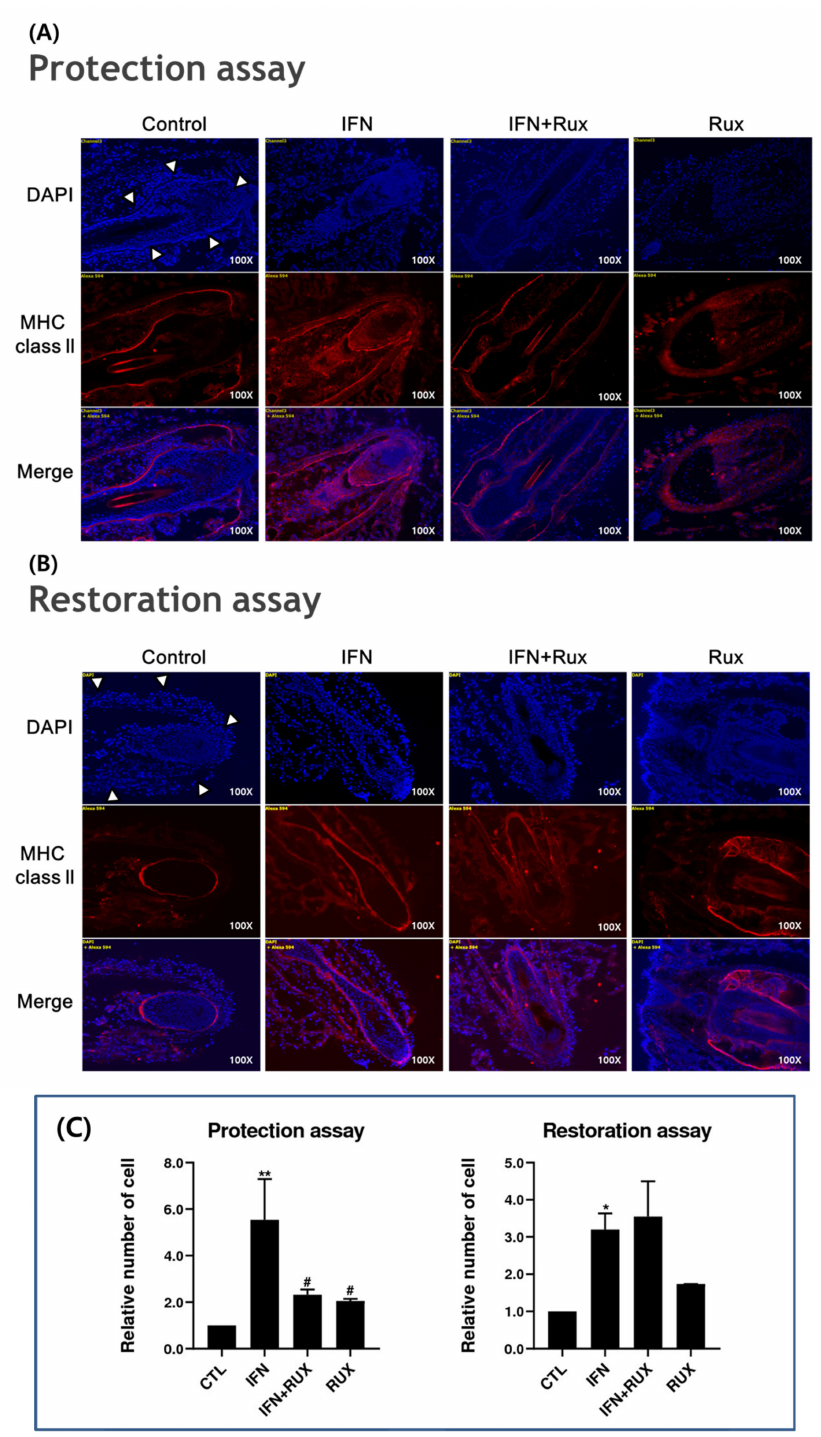
Figure 6. E ff ects of ruxolitinib treatment on hair-follicle organ culture. ( A ) Ruxolitinib pretreatment significantly prevented the induction of MHC class II molecule by IFN- γ in and around the hair follicles in the protection assay; ( B ) The expression of MHC class II molecule in the hair follicles ruxolitinib administered after treatment with IFN- γ was not e ff ectively suppressed in the restoration assay; ( C ) Relative number of immune-positive cells of MHC class II molecule in the protection and restoration assay. White arrowheads indicate outline of hair follicles. The data represent the means ± SEM, n = 3, statistically significant at * p < 0.05, and ** p < 0.01 compared to the control and # p < 0.05 compared to the IFN- γ -treated